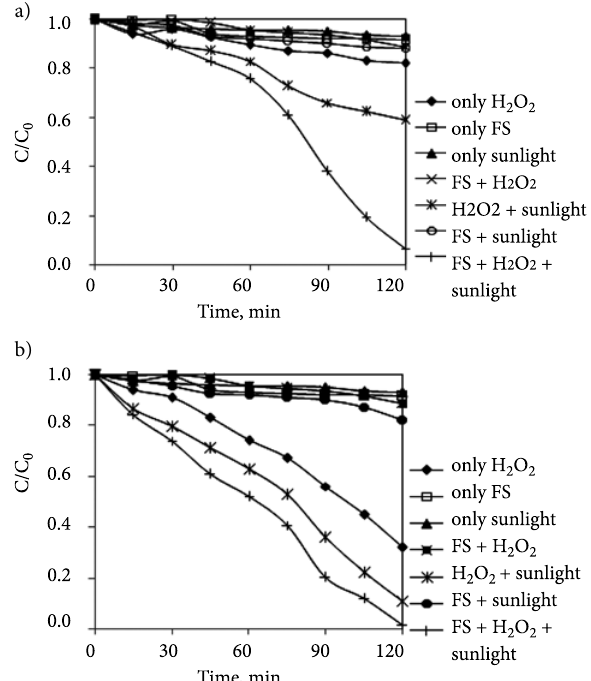
Fig. 4. Preliminary experiments performed under different conditions to evaluate their efficiency towards a) degradation